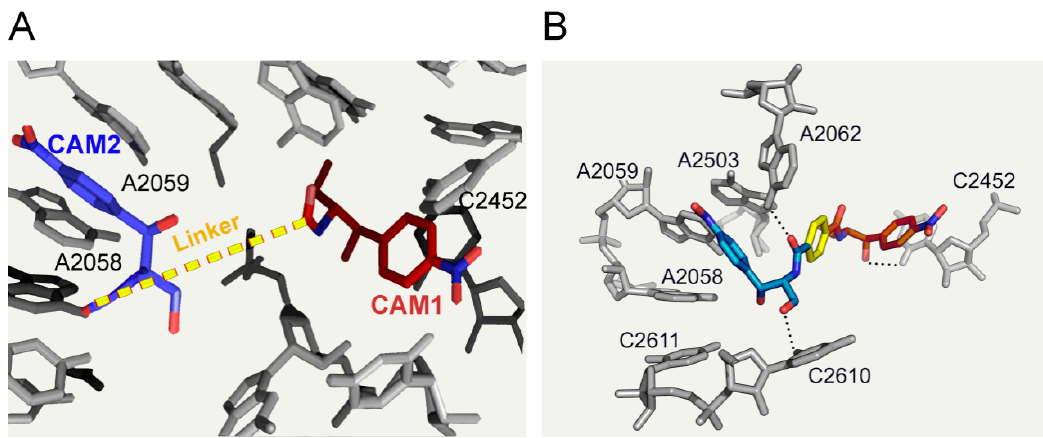
Figure 13. Rationale of CAM dimers designing and binding model of compound 43 . ( A ) Two CAM-binding sites in the Escherichia coli ribosome: at the left side, CAM is docked at the entrance to the ribosomal exit tunnel (CAM2) by simulating its crystallographic position in Haloarcula marismortui [5]; at the right side, CAM is docked at the A-site of the catalytic crevice (CAM1) by simulating its crystallographic position in Escherichia coli [19]. Both molecules are connected by a putative linker and embedded into a nucleotide environment taken from crystallographic data derived from Escherichia coli ; ( B ) Binding position of compound 43 (in blue, yellow and red) into the Escherichia coli 50S ribosomal subunit, as derived by MD simulations [6].